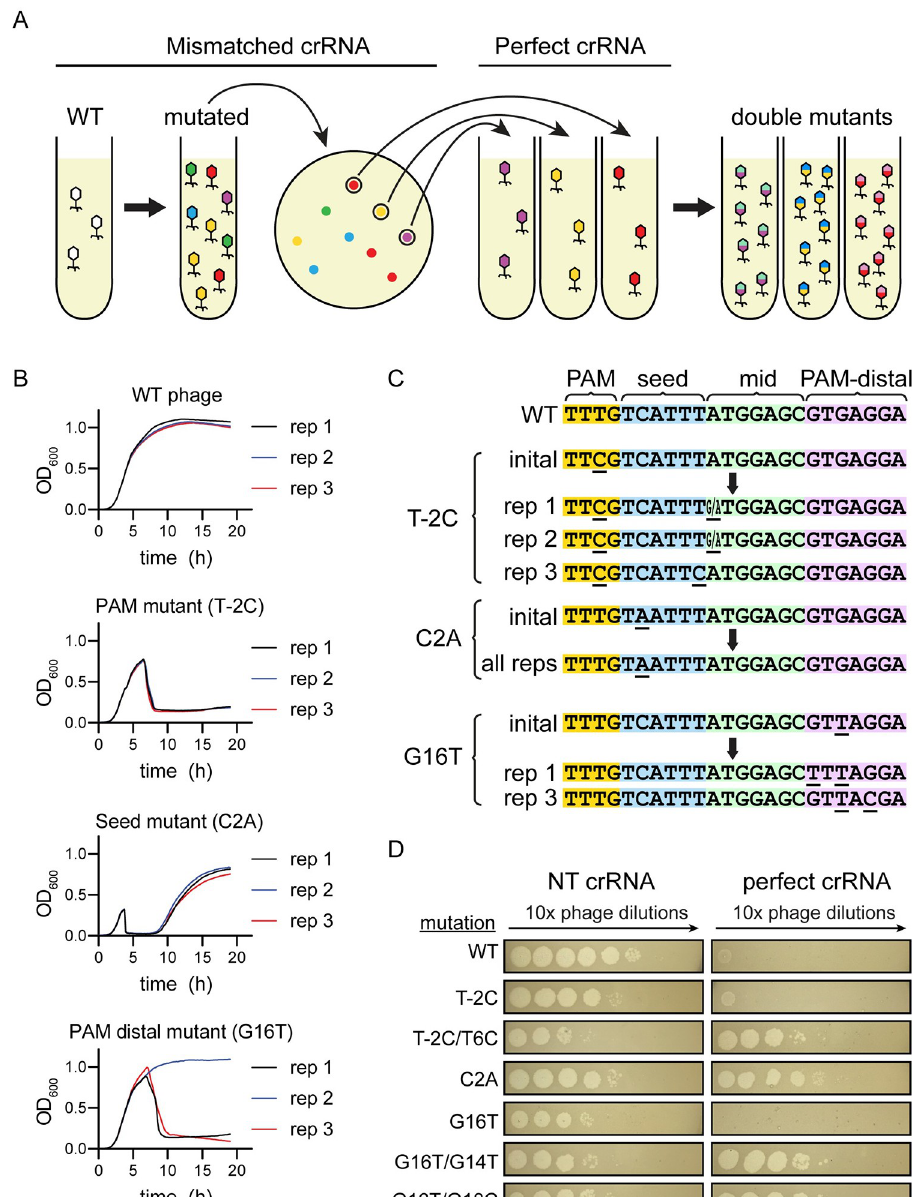
Fig 7. Generation of double-mutant phage is driven by insufficiently deleterious mutations. (A) Schematic of the process for generating and purifying single-mutant phage populations. Wild-type phage was used to challenge E . coli expressing a crRNA with a mismatch to the target in the phage genome in liquid culture. The resulting phage were isolated and used for a plaque assay on lawns of bacteria expressing the same mismatched crRNA. Single plaques were isolated and again used to challenge bacteria expressing a mismatched crRNA in liquid culture, further purifying and propagating single mutants. Finally, single-mutant phages were used to challenge bacteria expressing a perfectly matching crRNA in liquid culture to determine whether second mutations would appear. (B) Growth curves of bacteria expressing a perfectly matching crRNA challenged with wild-type phage and phage with various single target mutations. Locations of the single mutations in the target are labeled (PAM mutant, seed mutant, and PAM-distal mutant). Position and type of mutations are indicated in parenthesis. Three biological replicates are shown separately for each experimental condition. See S2 Data for quantified data. (C) Diagram of initial and selected mutations that appeared when a single-mutant phage was used to challenge bacteria expressing a perfectly matching crRNA. Initial mutants are single mutants that were generated and purified as described in (A). Sequences below arrows show phage mutants that appeared in different biological replicates (rep 1, 2, or 3) after initial mutant phage lysates were used to infect bacteria expressing a perfectly matching crRNA in liquid culture. Positions with ambiguous base calls